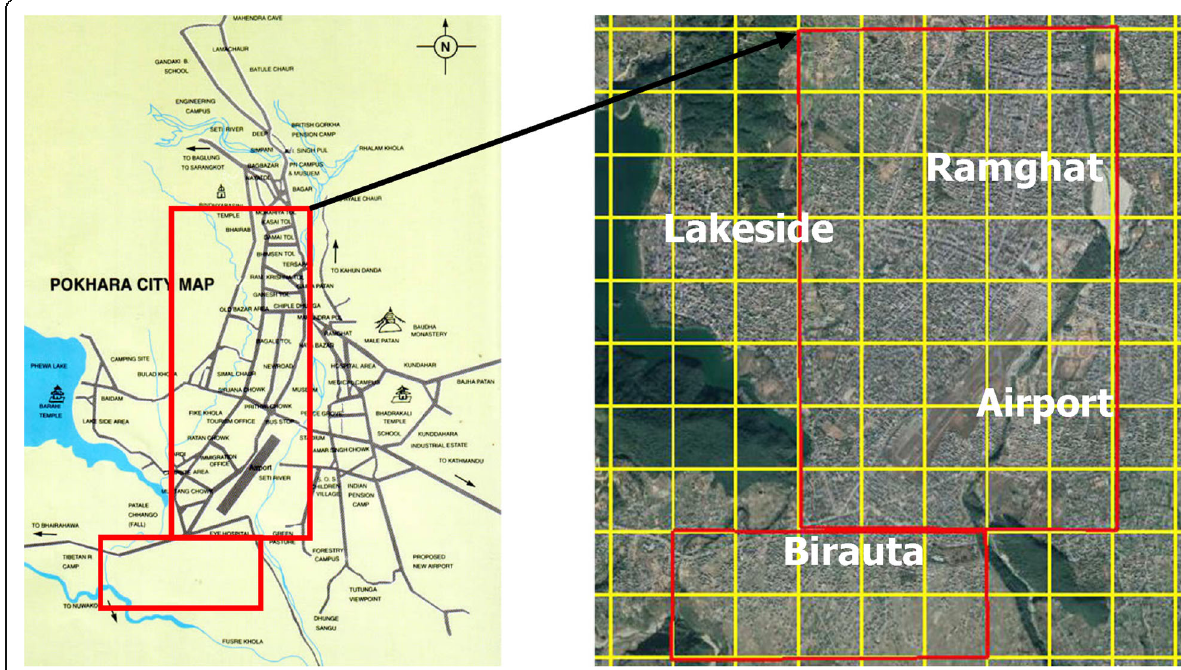
Fig. 2 Illustration of grid based data collection from local resident (source of base map: Tourist map of Pokhara and GoogleEarth). The red area is used for data